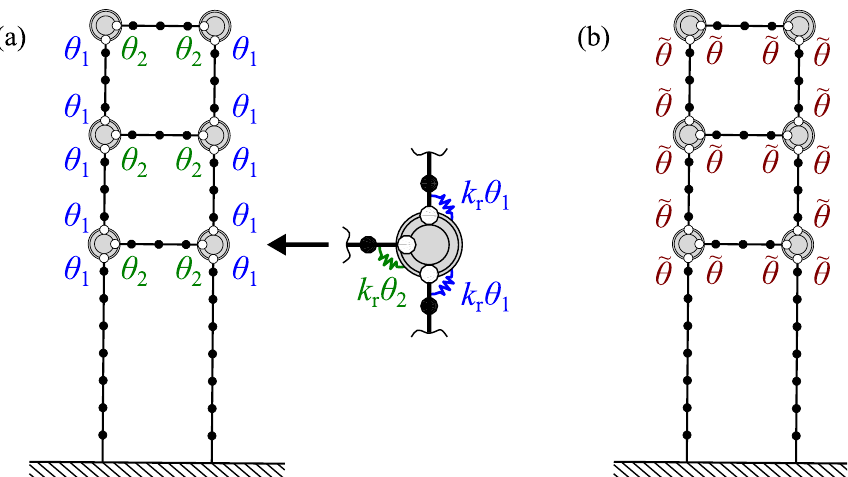
Figure 3. Mesh and parameterization of FE models: ( a ) independent parameterization for vertical ( θ 1 ) and horizontal ( θ 2 ) bolted connections and ( b ) common parameter (cid:101) θ for all bolted connections.